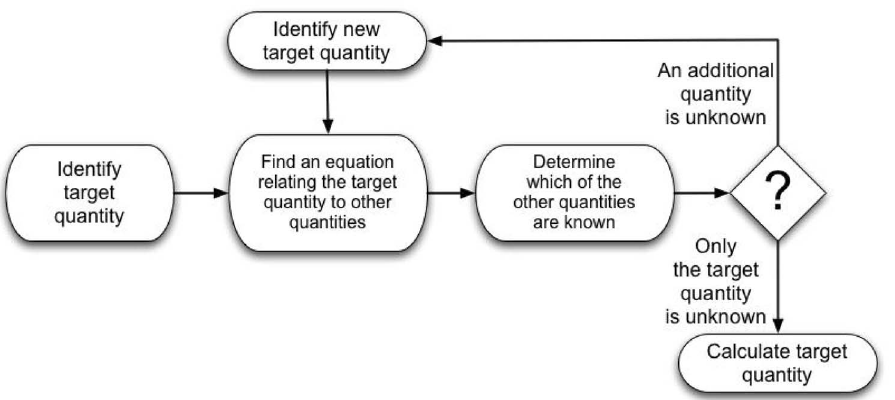
FIG. 5. Schematic diagram of some moves in the epistemic game Recursive Plug-and-Chug.